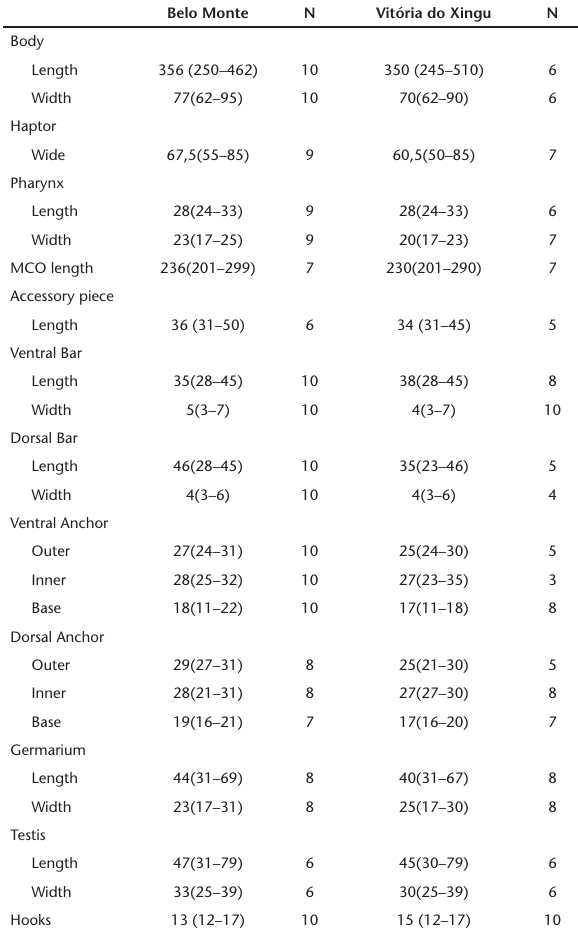
Table 3. Comparative measurements (μm) of specimens of Cosmeto- cleithrum phryctophallus sp. nov. from the gills of Hassar orestis from two locations. MCO = male copulatory